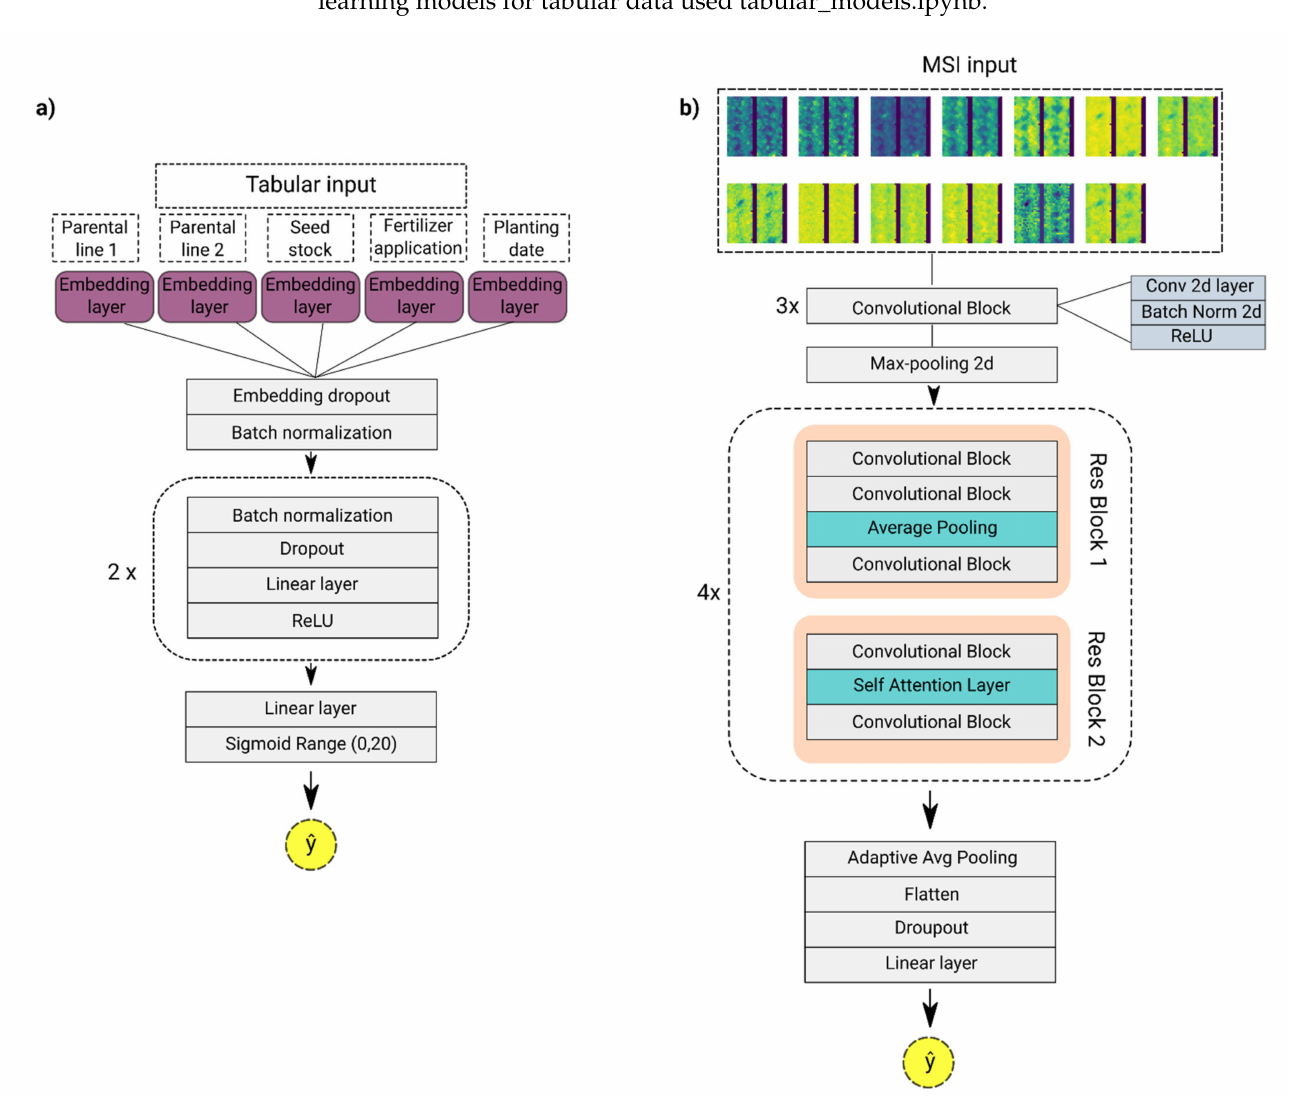
Figure 2. Schematic representation of the deep learning model architectures; ˆy indicates the yield prediction output by the model. In ( a ) and ( b ), some layer blocks are repeated, as indicated by the dotted line. ( a ) Tab-DNN architecture with embedding layers. The tab-DNN is trained based on genotype and crop management data, as indicated in the image. ( b ) The sp-DNN architecture is based on a modified resnet18 with a self-attention layer. The sp-DNN was trained with the spectral images plus vegetation indices bands, calculated per pixel. The self-attention layer is present once in the first block repetition, whereas the average pooling layer is not present in the first block